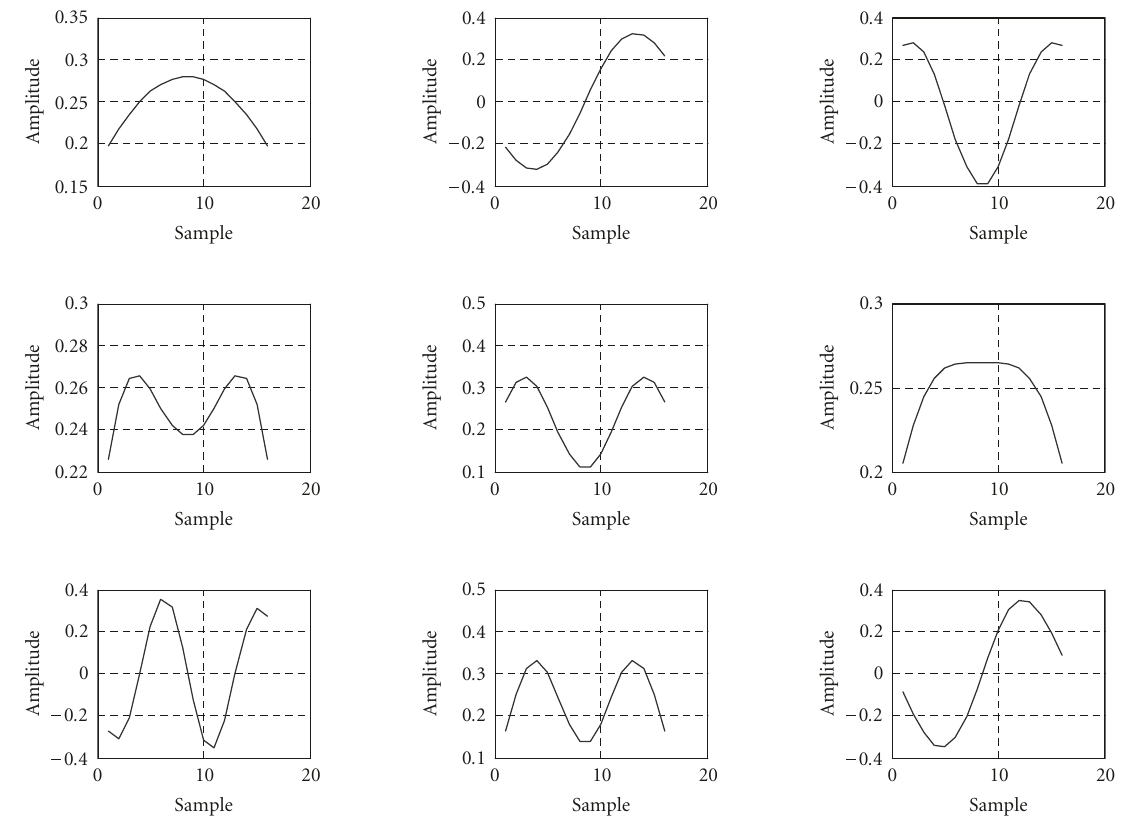
Figure 3: Some selected unique signature vectors in the predefined signature set for L F =